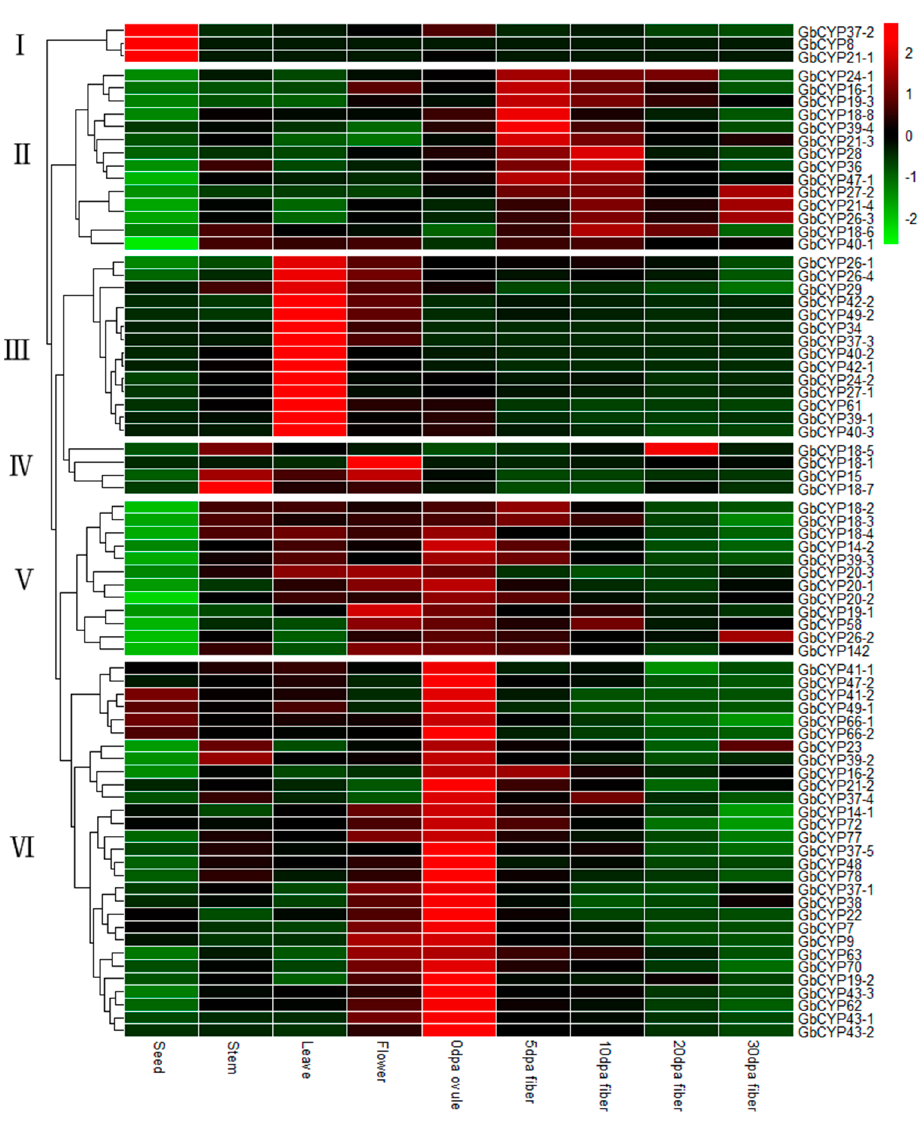
Figure 7. Expression patterns of GbCYP genes in different tissues. Nine tissues comprising seeds, stems, leaves, flowers, 0 days postanthesis (DPA) ovules, and 5, 10, 20 and 30 DPA fibres were investigated. Scale bars represent the log2 transformations of the RPKM values. The results can be classified into six pattern groups (I–VI).